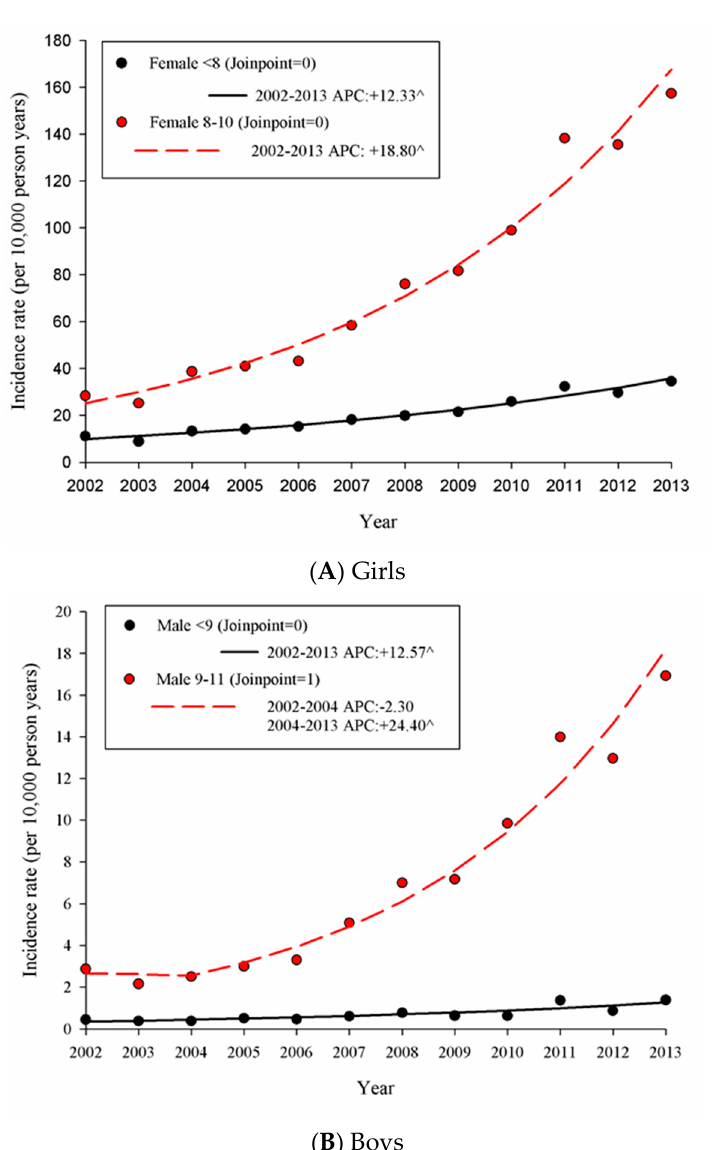
Figure 2. The trend of the PP incidence rate in ( A ) girls and ( B ) boys from 2002 to 2013, where the symbol “^” indicates that the annual percent change (APC) was significantly different from zero.